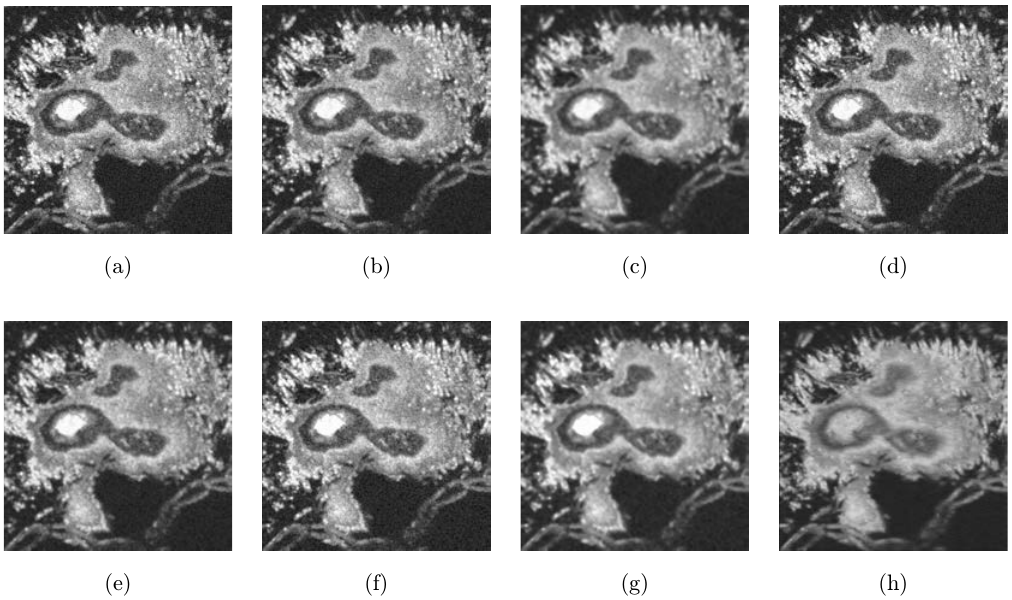
Fig. 4. Noise reduction for the image of implant under the layer of mouse skin using the di®erent methods.